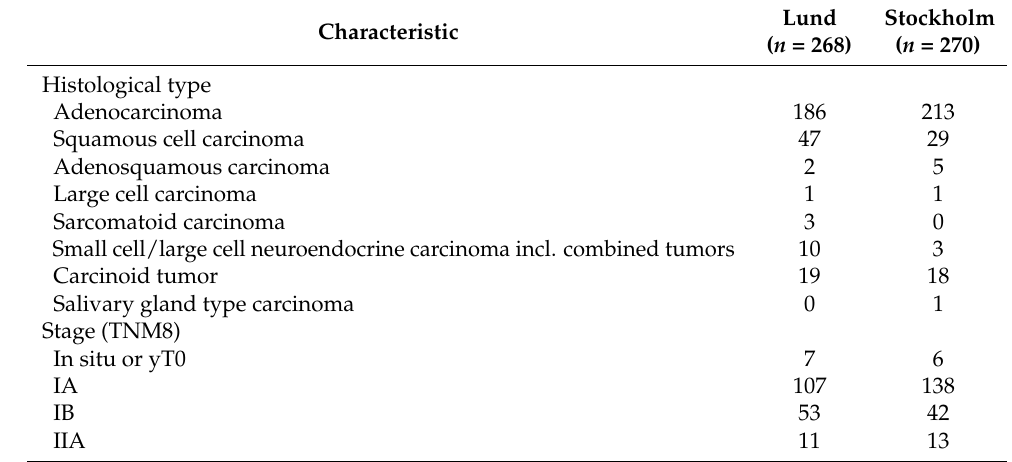
Table 1. Characteristics for consecutive surgically treated primary lung cancer from a 15-month